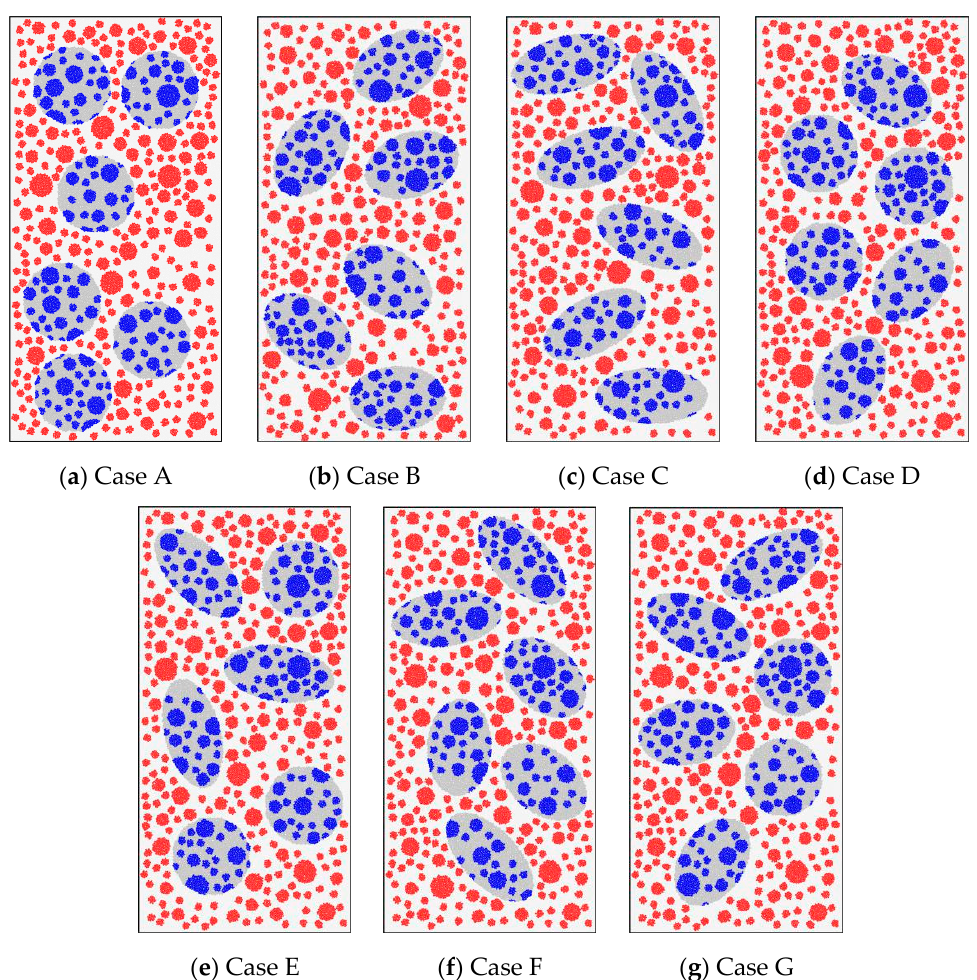
Figure 13. Recycled lump concrete containing DCLs with different shapes.